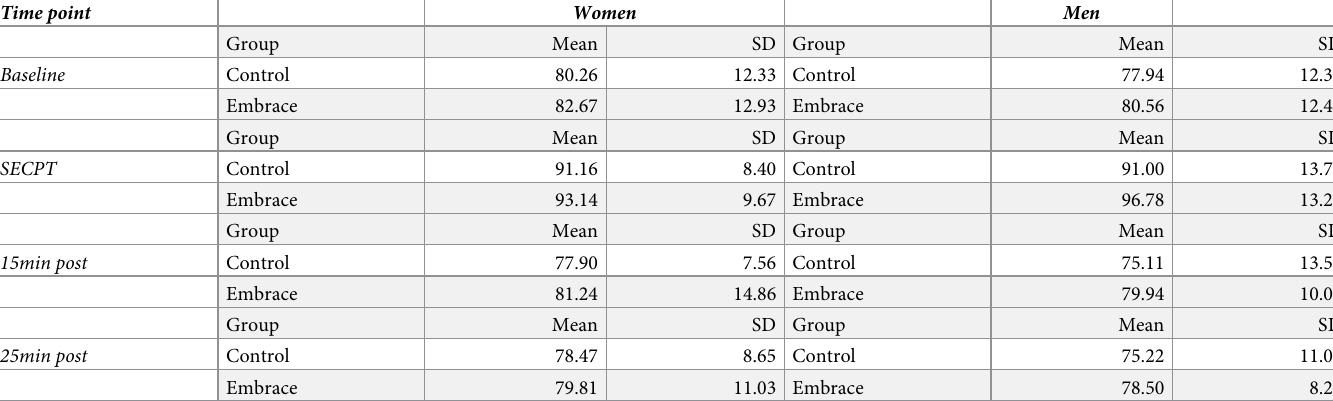
Table 3. Descriptive values (mean value and standard deviation) of diastolic blood pressure values across the four measurement time points broken down by condi- tion and sex. Time point